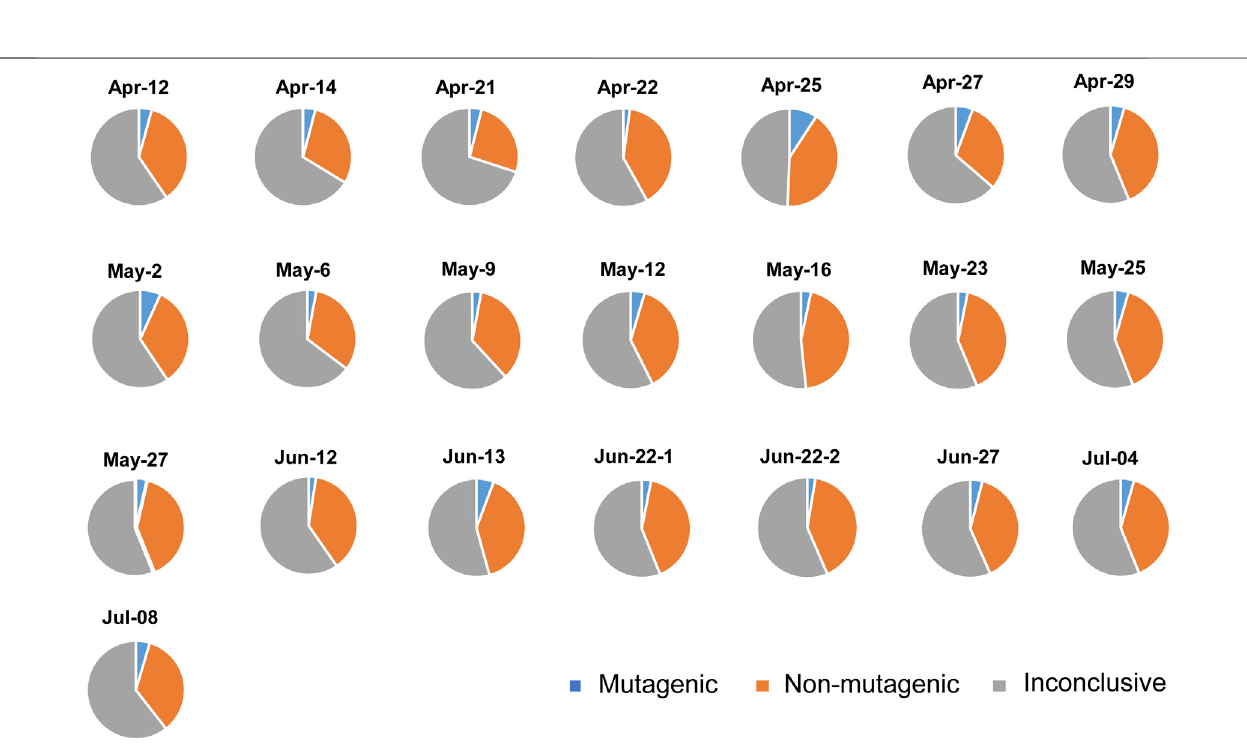
Frontiers in Environmental Science |